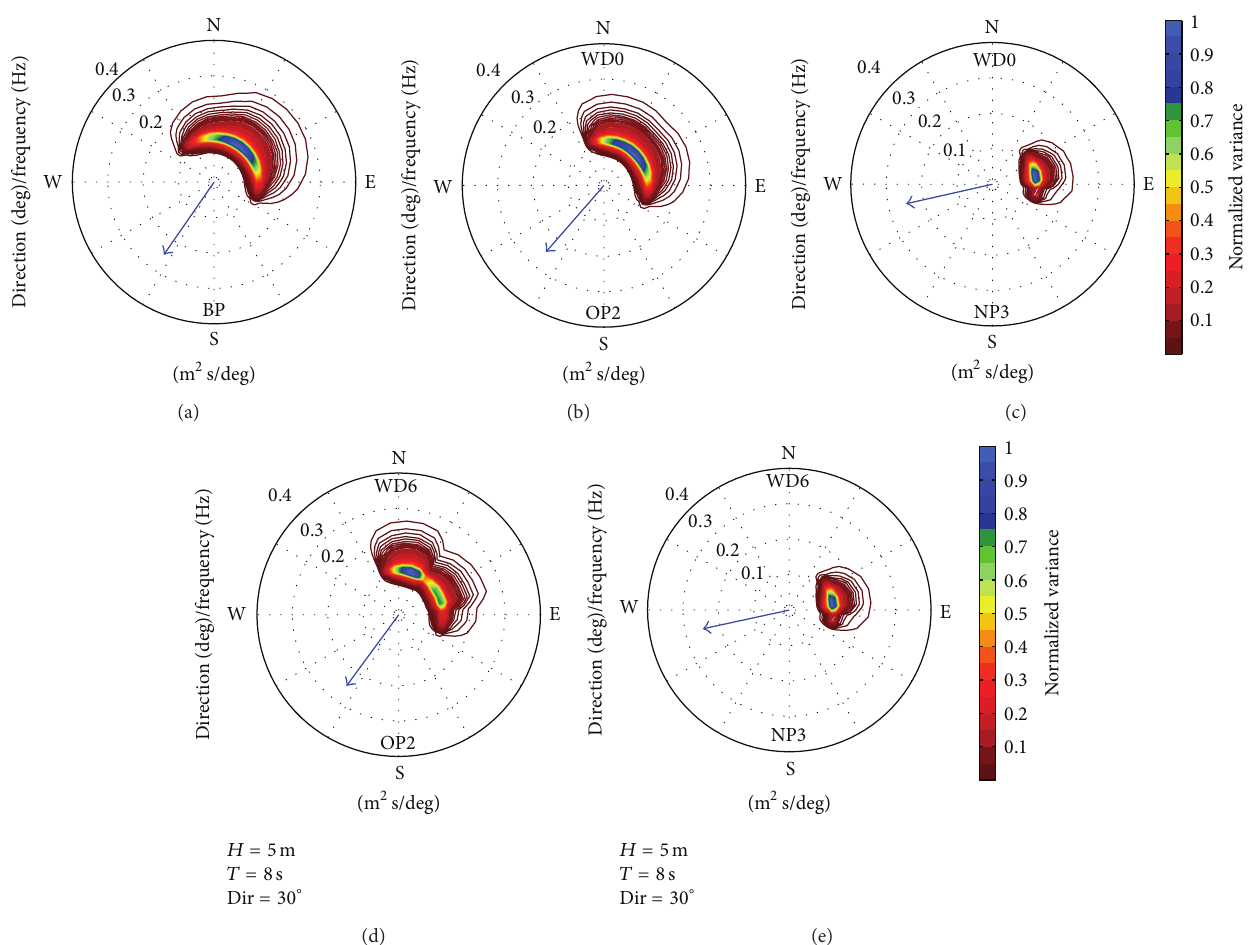
Figure 16: Evaluation in the spectral space of the impact on the wave field of a wave farm based on Wave Dragon WECs that operate in the target area for an additional case study defined by the parameters 𝐻 𝑠 = 5 m, 𝑇 𝑚 = 8 s, Dir= 30 ∘ . (a) BP for WD0. (b) OP2 for WD0. (c) NP3 for WD0. (d) OP2 for WD6. (e) NP3 for